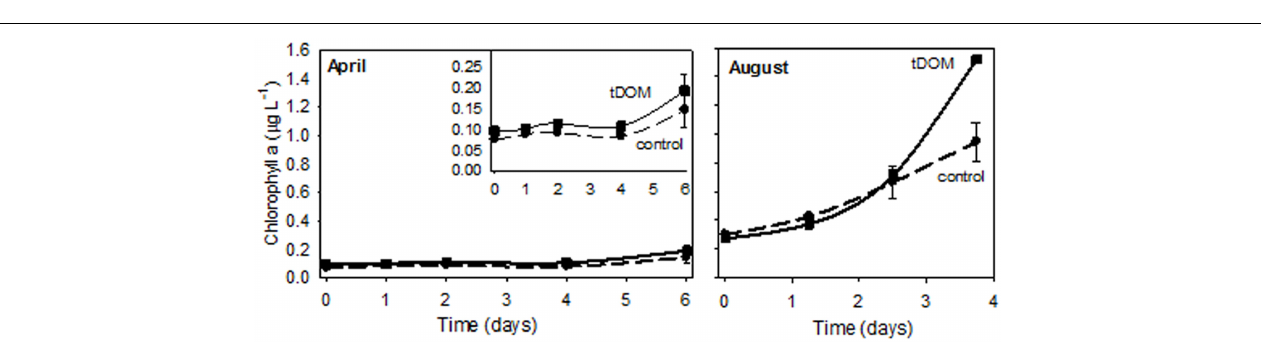
FIGURE 3 | Bacterial response to tDOM additions. Time series of bacterial abundance (A) and bacterial production (B) data for the April bioassays where near coastal Arctic microbial communities were amended with terrestrially derived dissolved organic matter (tDOM). Data points are the mean ( n = 2) ± half the range of duplicate samples. The tDOM treatment is depicted by the solid line and the Control treatment, which contains no additional DOM, is depicted by the dashed line.